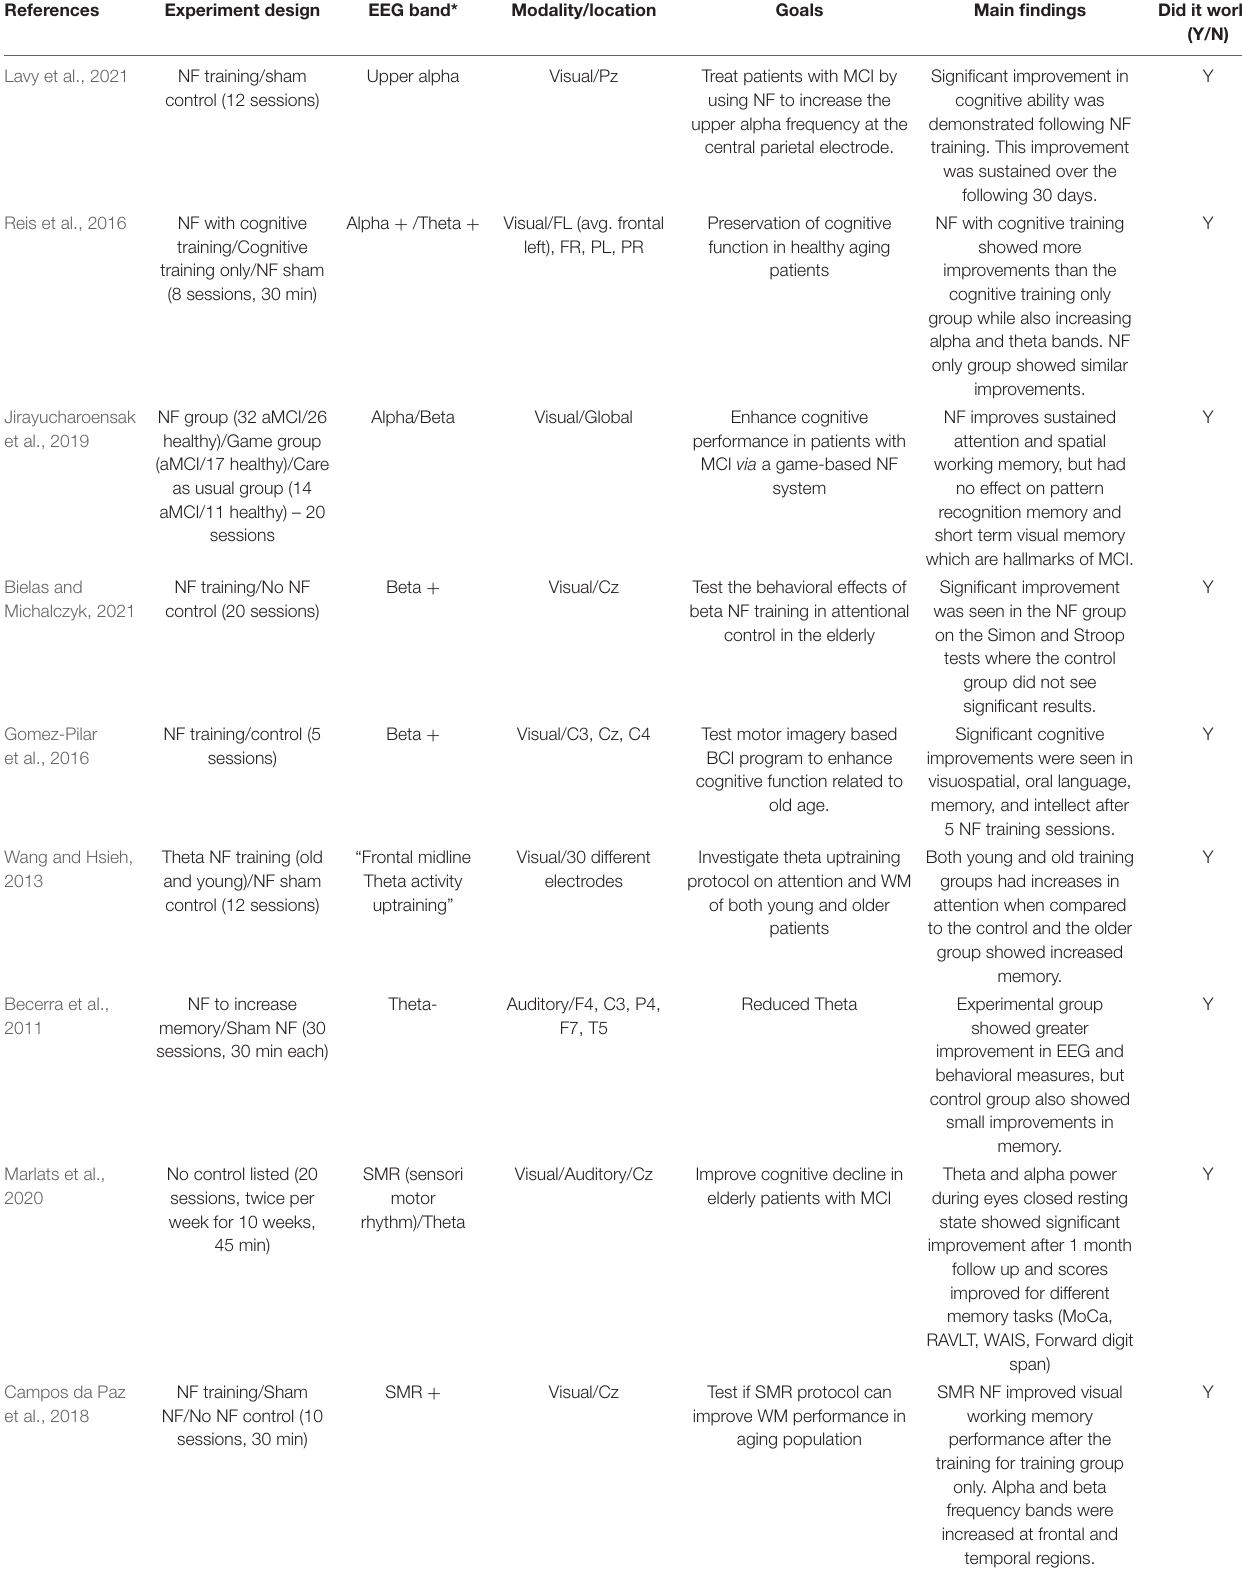
TABLE 1 | Sample NF training in older adults with or without